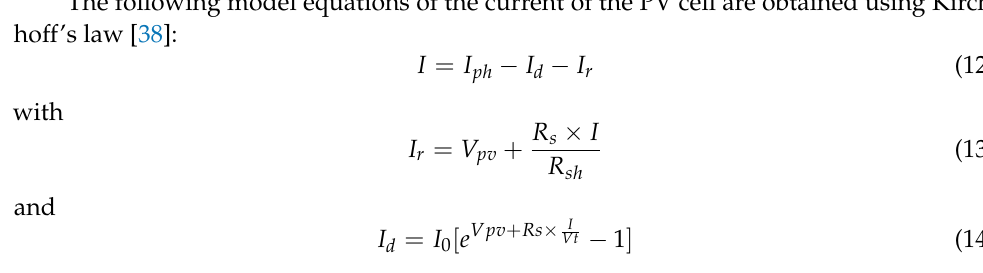
Figure 6. Equivalent circuit of the solar cell with a single diode .